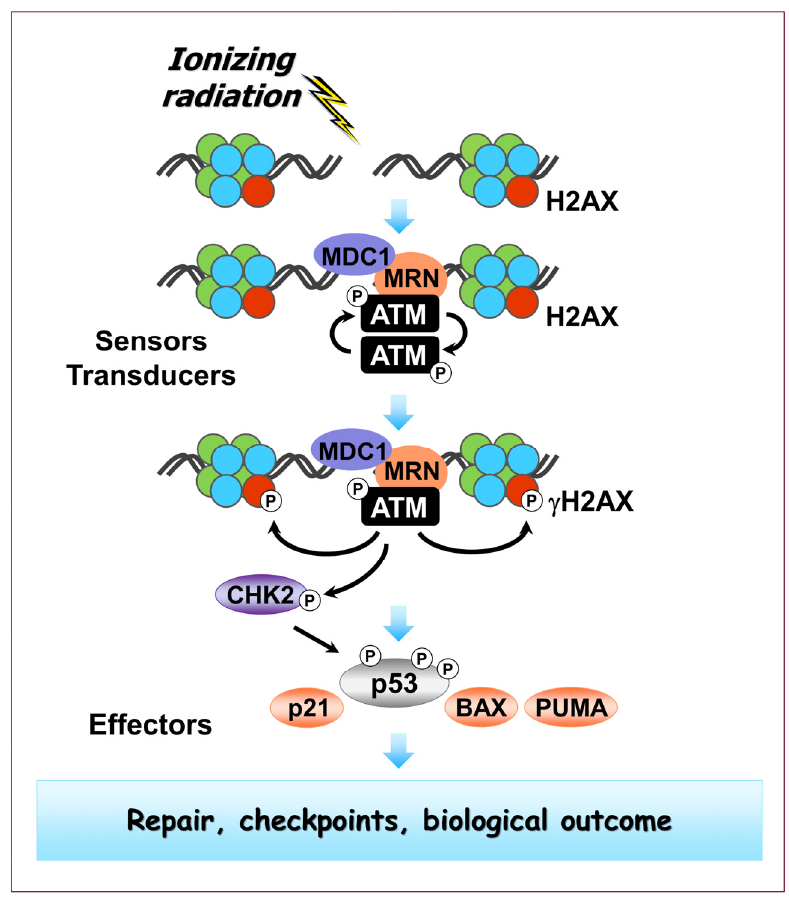
Figure 1. Highly simplified schematic of the radiation-triggered DNA damage response discussed in this article. Open circles containing “P” indicate phosphorylation